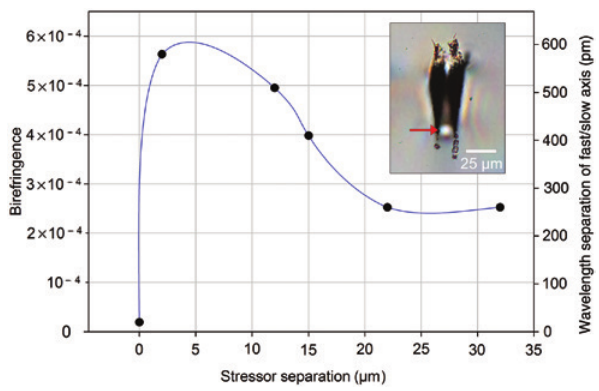
Figure 14: WBG birefringence induced by neighbouring stress tracks written with a circularly polarised beam in a silicate glass. The inset shows 13 m m spaced stressors written with 400 fs, 5 m J, 1 kHz pulses surrounding a WBG under bright-field illumination. The arrow indicates the location of the